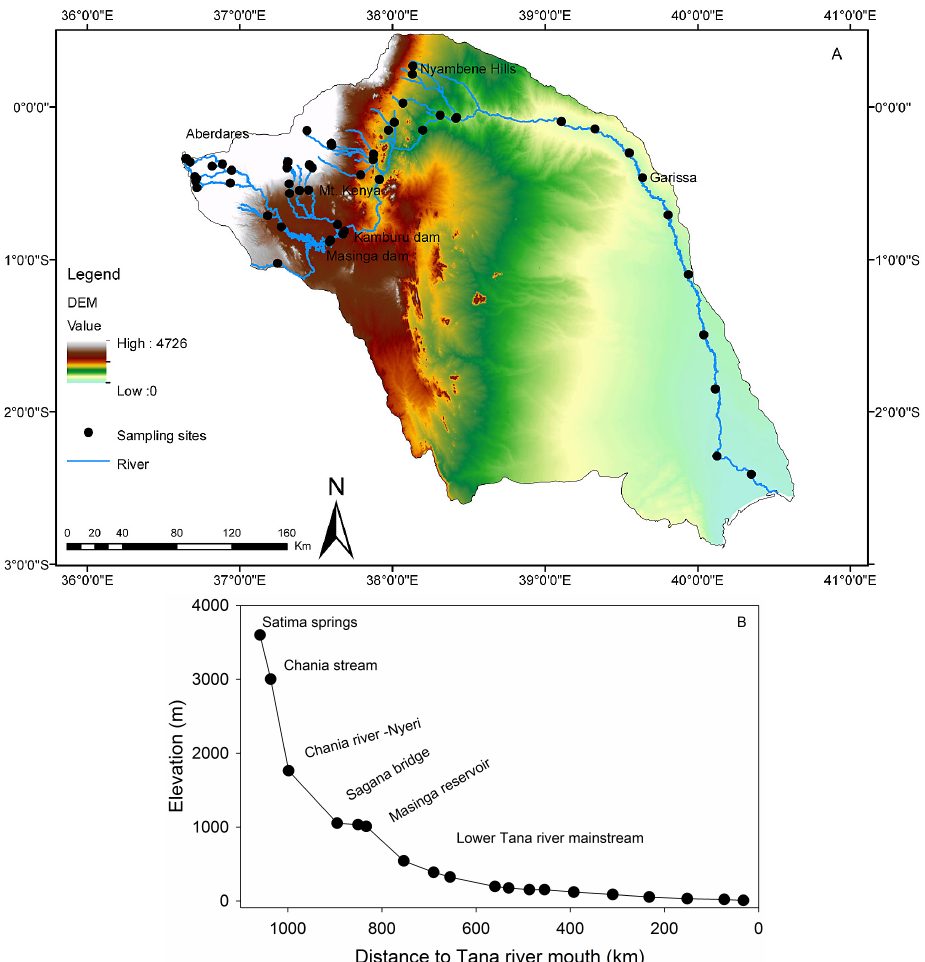
Fig. 1. (A) Digital Elevation Model (DEM) of the Tana River Basin, which consists of two main geographical units, the Tana headwaters and the main lower Tana. The 57 sampling sites are indicated by black dots. (B) Profile of the Tana River from headwaters to Tana mouth. Sampling stations for the lower Tana River are indicated, as well as a selected number of headwater sampling sites to show their overall